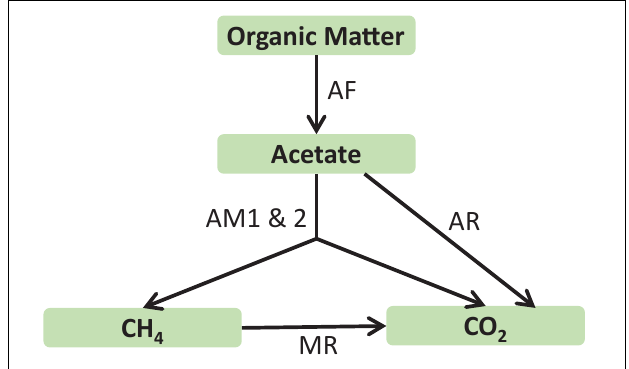
FIGURE 5 | Microbial reaction network in the profundal sediments of Lake Constance, Germany. AF, acetate production from organic carbon by fermenting microbes; AM1 and 2, acetoclastic methanogenesis by Methanosarcina and Methanosaeta , respectively; AR, acetate oxidation by aerobic respiration; MR, methane oxidation by aerobic